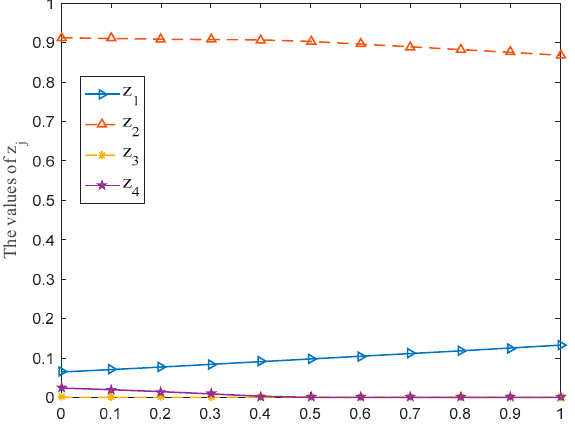
Figure 9. z j with parameter η varying from 0 to 1.